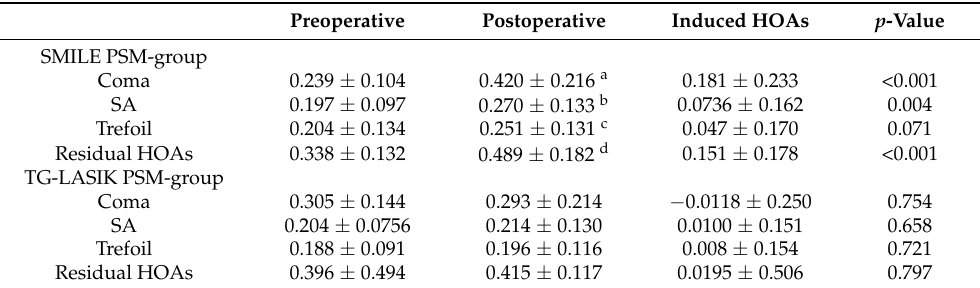
Figure 5. Comparison of corneal HOAs in TG-LASIK and SMILE propensity-score-matched groups. (TG-LASIK, topography-guided laser-assisted in situ keratomileusis; SMILE, small-incision lenticule extraction; SA, spherical aberration; HOA, higher-order aberration; * p < 0.05; ** p < 0.01; ns: not significant). Table 3. Changes in corneal higher-order aberrations in both propensity-score-matched groups after each refractive surgery.